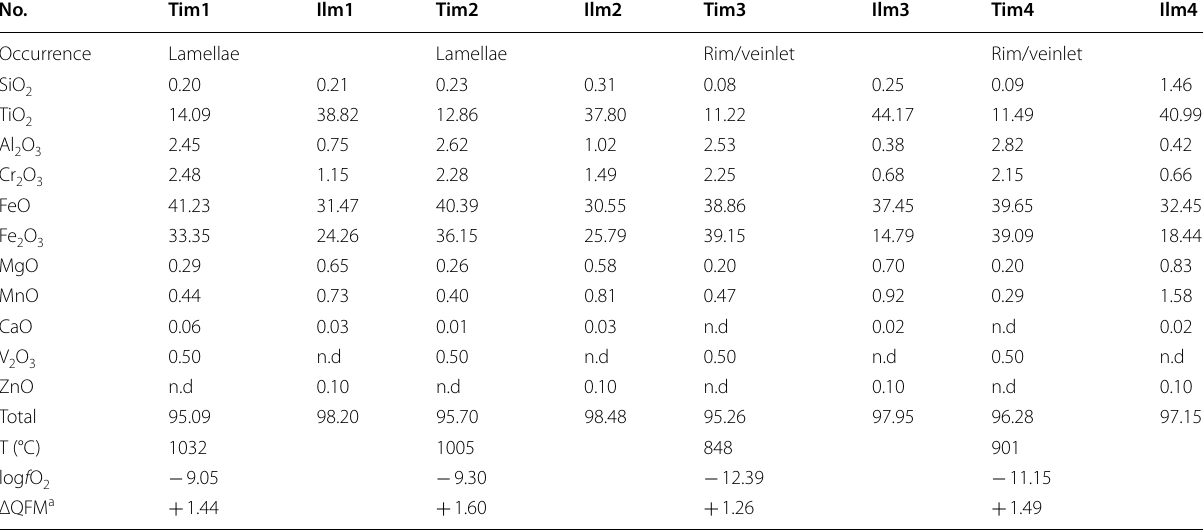
Table 1 Fe–Ti oxide compositions calculated based on